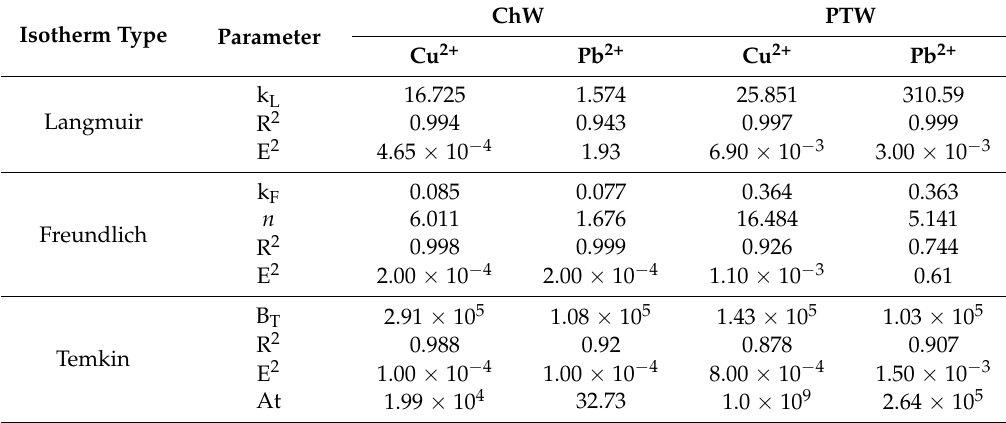
Table 3. The parameter of the adsorption